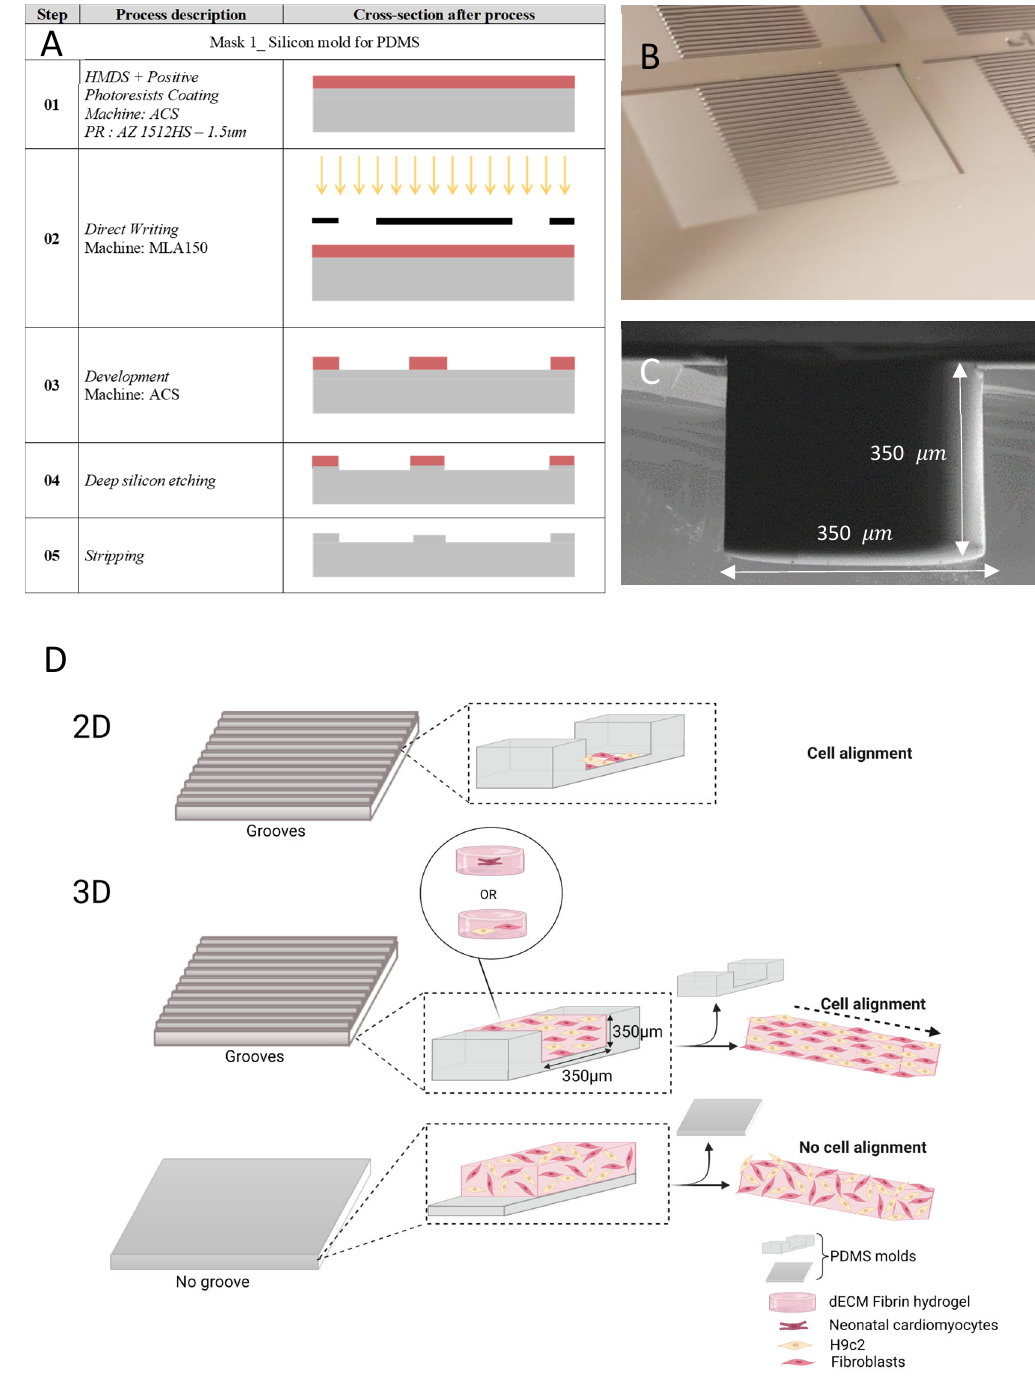
Figure 1. The process of chip fabrication and schematic of the work. ( A ) the main steps of groove microfabrication. ( B ) Etched silicon wafer for fabricating the microgrooves. ( C ) SEM pictures of microfabricated grooves patterned in silicon wafer. ( D ) schematic describing the alignment in 3D cardiac model.